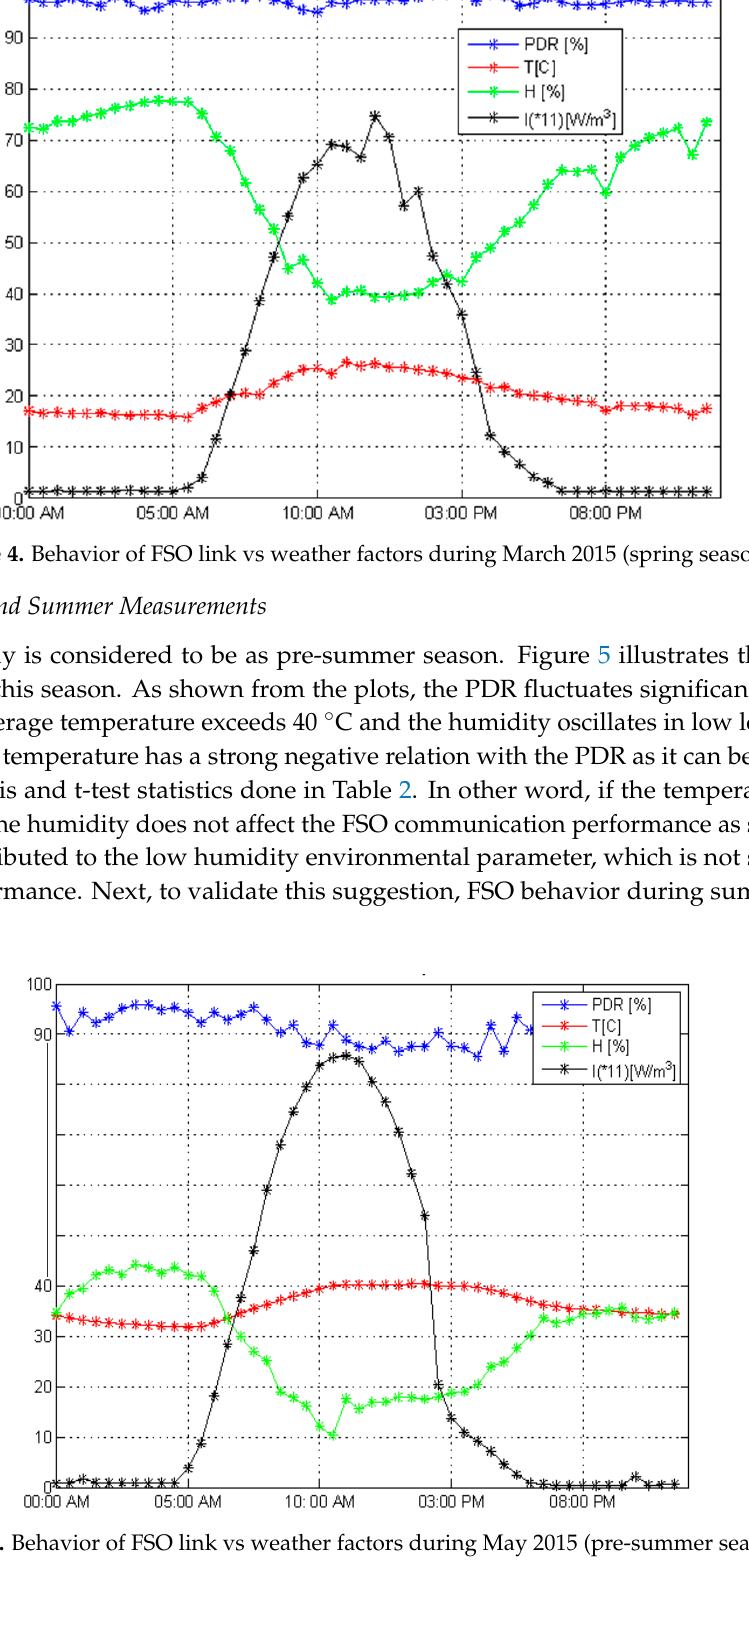
Figure 5. Behavior of FSO link vs weather factors during May 2015 (pre-summer season).